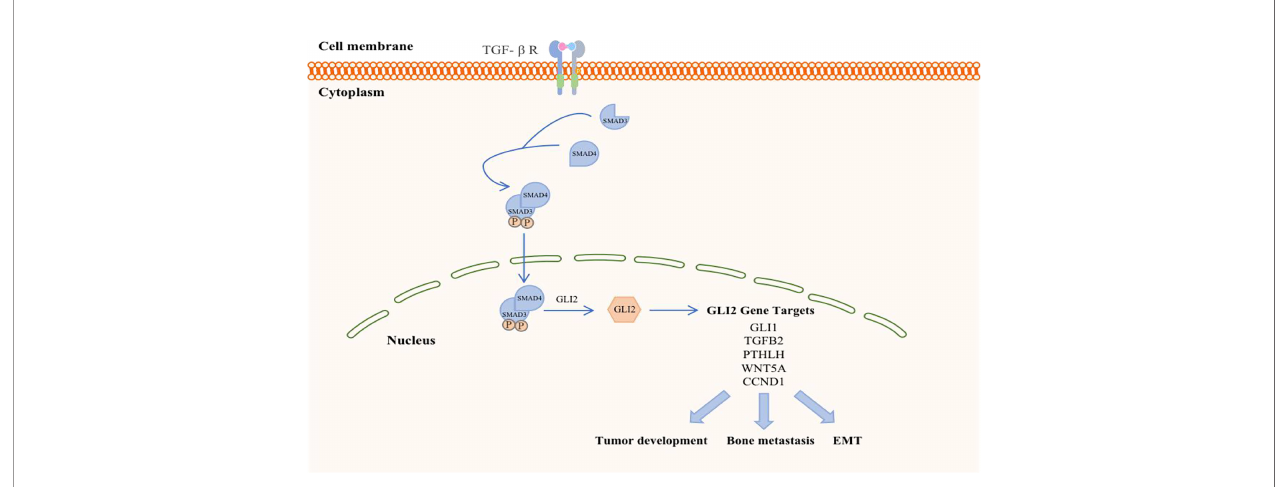
FIGURE 3 | Schematic representation of TGF- b in breast cancer. TGF- b ligand activation of speci fi c cell surface serine – threonine kinase receptors activates the SMAD cascade, resulting in transcriptional activation of the GLI2 gene. GLI2 protein may either regulate target gene expression and exert prooncogenic activities downstream of TGF- b